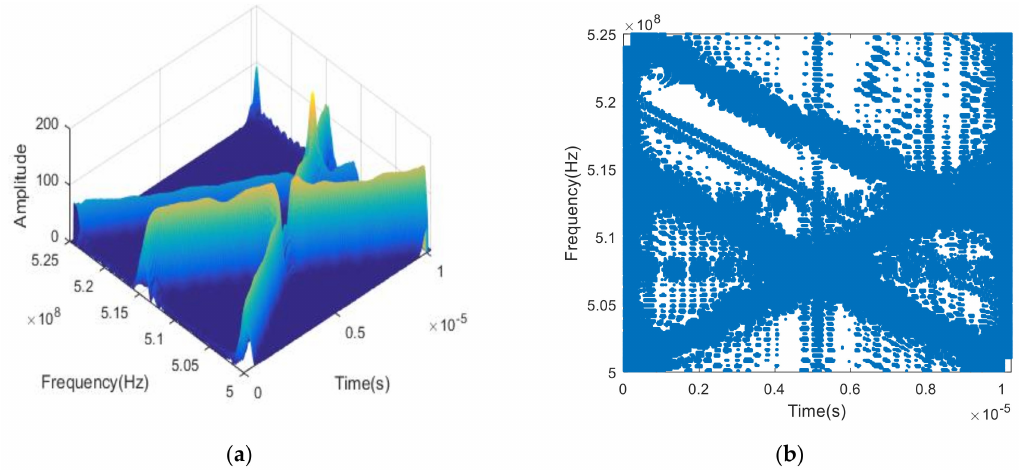
Figure 2. Time-Frequency Distribution of received signals. ( a ) Time-Frequency Distribution (3-dimensional); ( b ) Time-Frequency Distribution (2-dimensional).